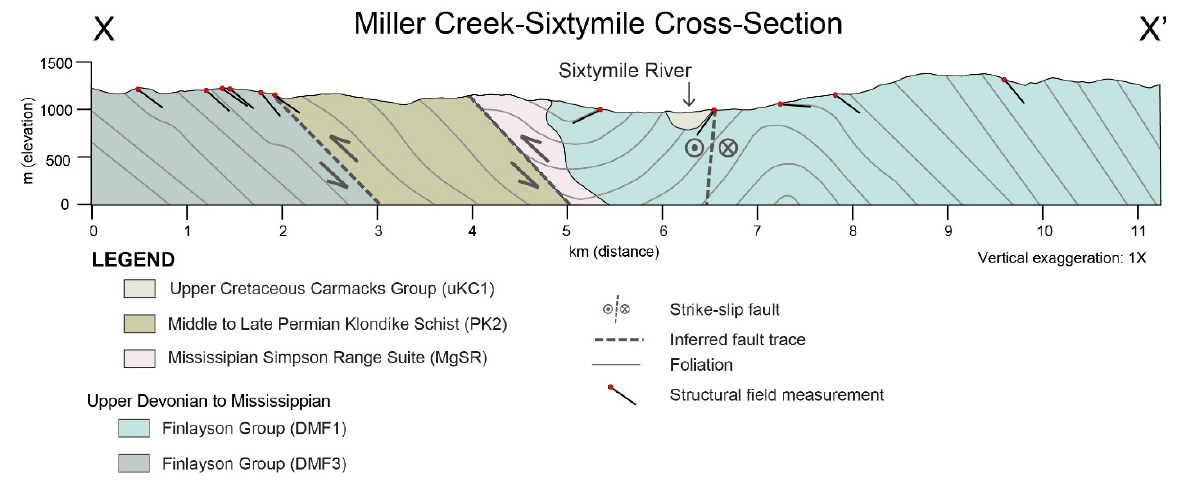
Figure 8. Geologic cross-section along Miller Creek and across the Sixtymile River. See Figure 2 for the location of this cross-section.